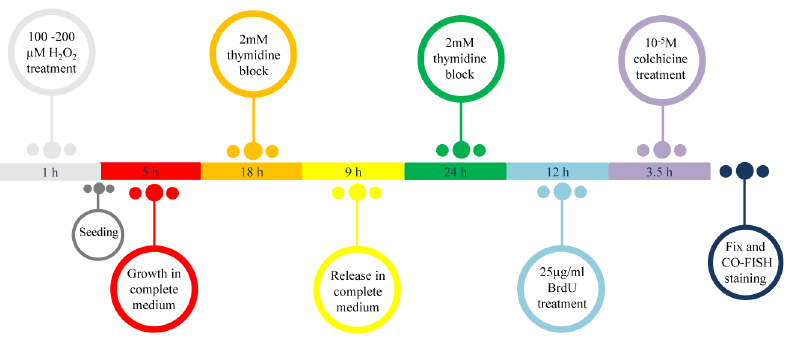
Figure 1. Schematic representation of the cell synchronization protocol and the metaphase preparation timing. After 1 h of treatment with 100 and 200 µ M H 2 O 2 , cells were trypsinized and seeded in petri dish. After 5 h, the cells were incubated for 18 h in 2 mM thymidine, released in a complete medium for 9 h and then treated again for 24 h with 2 mM thymidine. Then the cells were treated with 25 µ g/mL of BrdU for 12 h and incubated for 3.5 h in 10 − 5 M colchicine. At the end the cells were fixed to obtained metaphases and processed by CO-FISH.